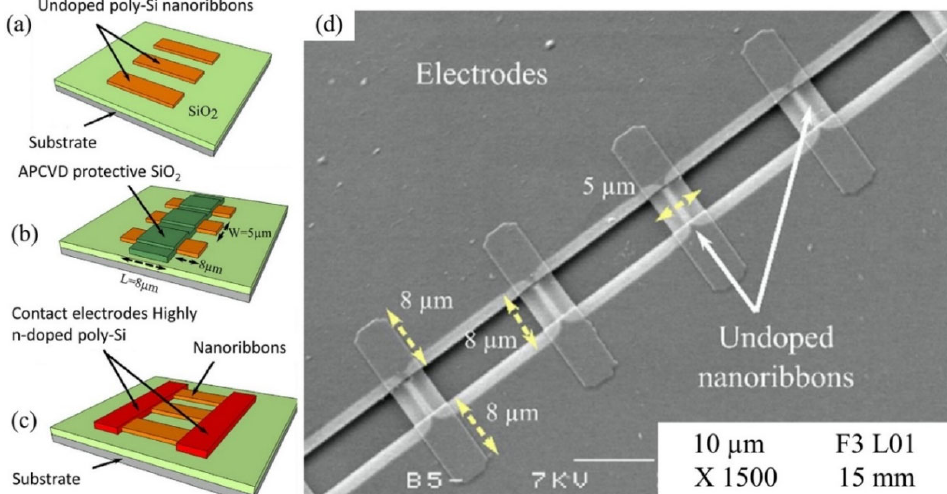
Figure 5. Construction of resistor sensor for Pb 2+ ( a ) Deposition of poly ‐ Si nanoribbons electrode on silicon wafer substrate ( b ) Deposition of insulating layer of SiO 2 by atmospheric pressure chemical vapor deposition (APCVD) ( c ) Deposition of contact electrodes on poly ‐ Si nanoribbons and removal of the SiO 2 protective layer and ( d ) SEM image (top view) of the resistor sensor. Reprinted from [105], Copyright 2018, with permission from Elsevier.